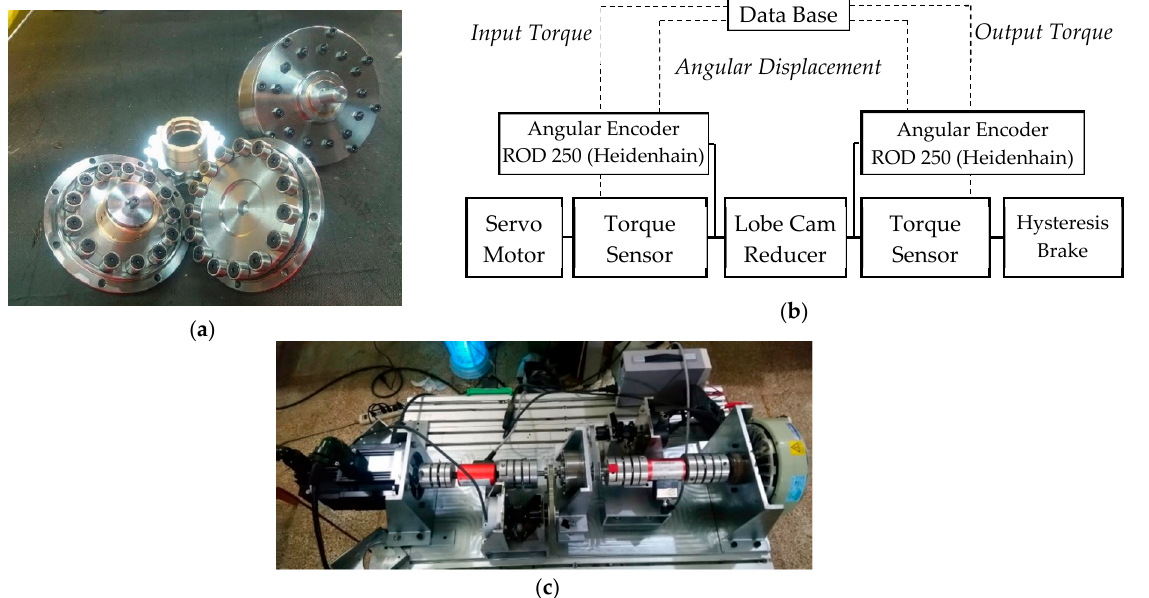
Figure 7. Contact stress analysis for conjugate lobe cam reducer I: ( a ) the input lobe cam and ( b ) the output lobe cam.